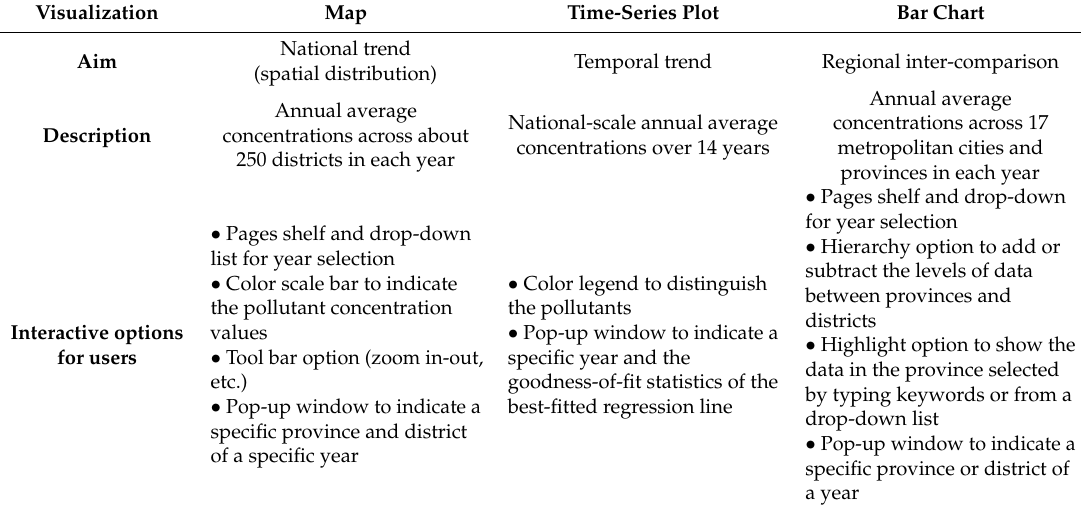
Table 1. Aims, description, and interactive options of three types of plots on the Tableau dashboards for visualizing measured and predicted concentrations of particulate matter with an aerodynamic diameter ≤ 10 µ m (PM 10 ) and nitrogen dioxide (NO 2 ) in South Korea,